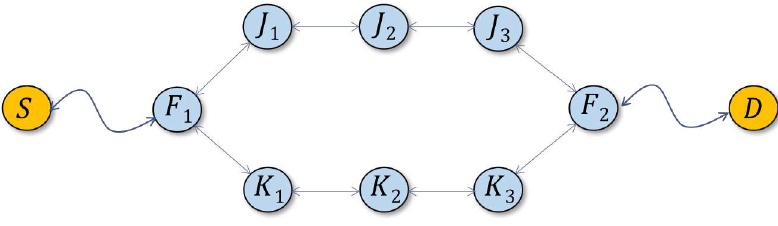
Figure 4. Multiple shortest